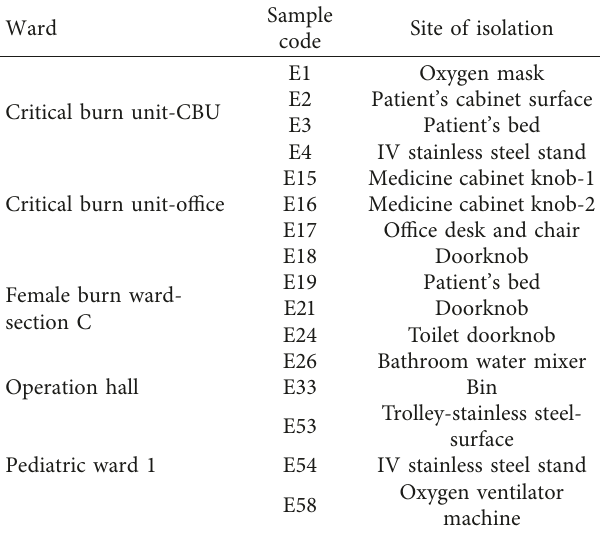
Table 3: Source of A. baumannii isolates from environments in different hospital